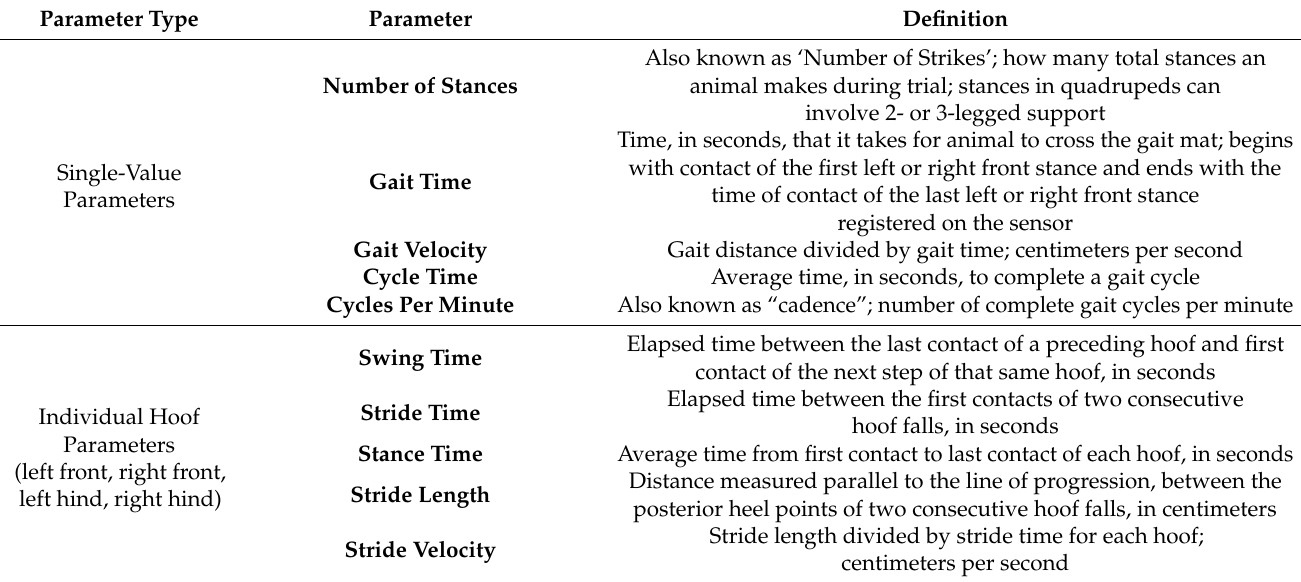
Table 2. Parameter